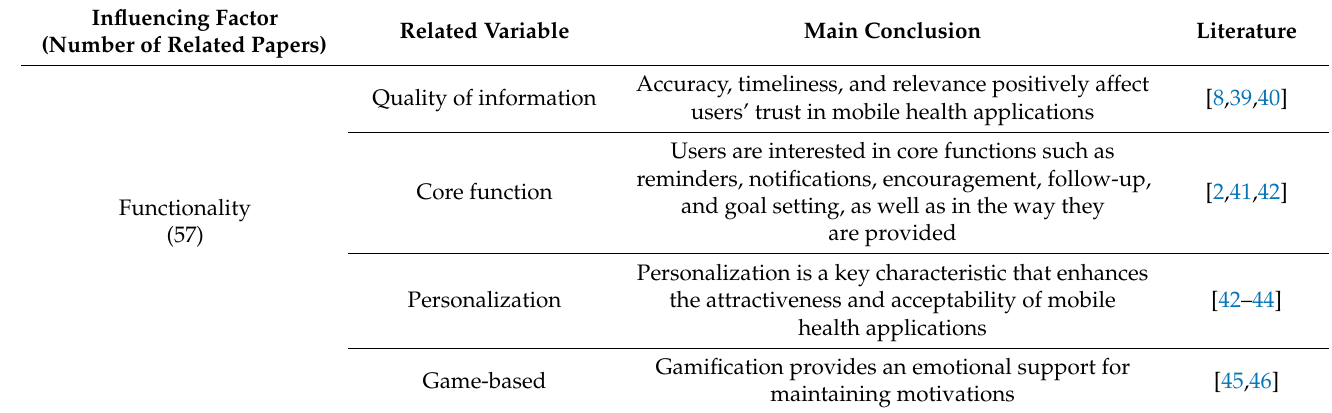
Table 4. Influence of App design in use